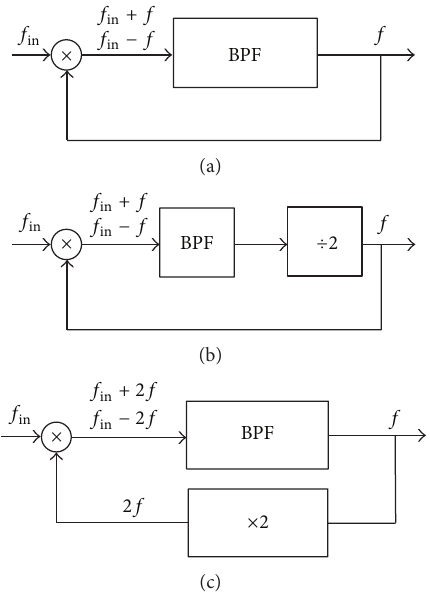
Figure 1: (a) Model of the Miller divide-by-two ILFD [2]. (b) Model of a divide-by-three ILFD based on a divide-by-two ILFD [7]. (c) Model of a divide-by-three ILFD based on a frequency multiplier [8].